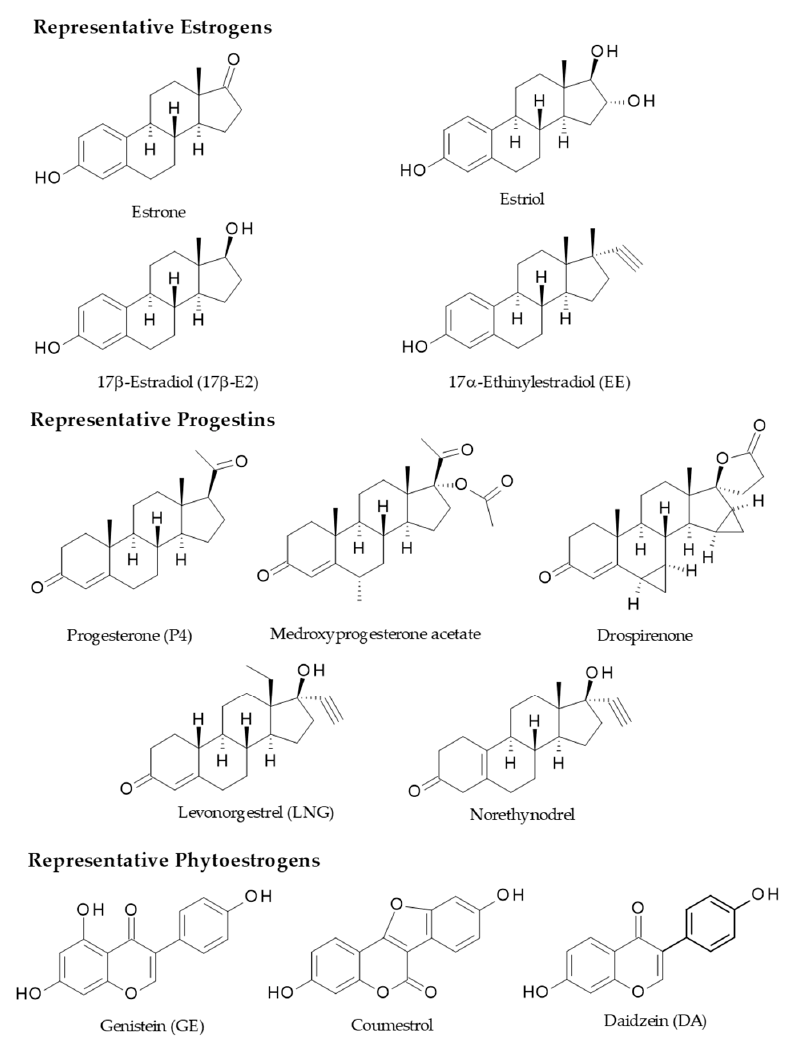
Figure 3. Chemical structure of representative estrogens, progestins, and phytoestrogens.